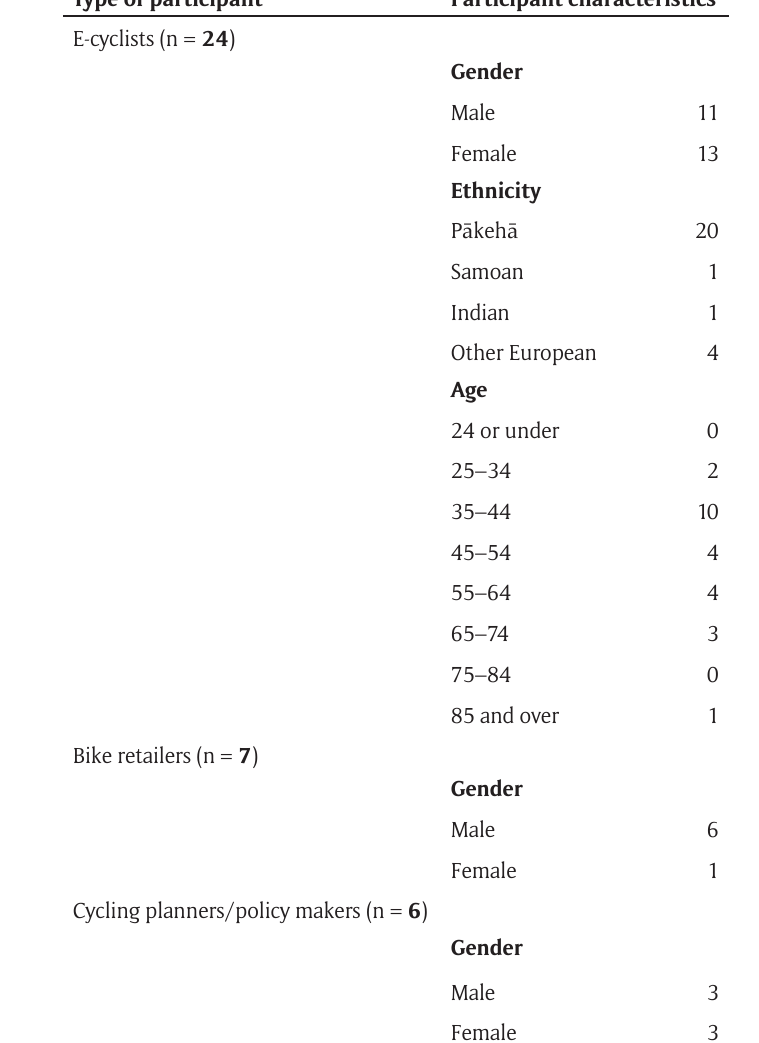
Table 1: Participant